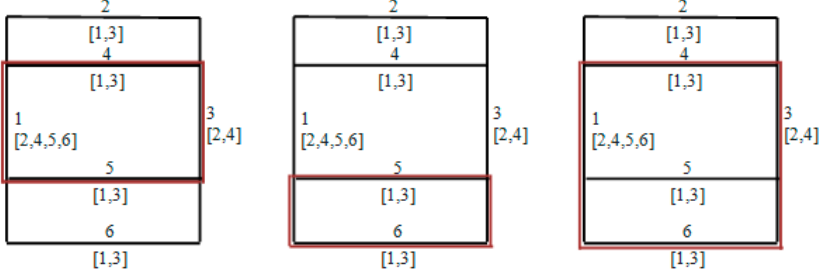
Figure 6. Automatic exclusion of contained rectangles: the three rectangles in red do not satisfy the rule for growing IDs of their segments, therefore they are discarded by the automaton